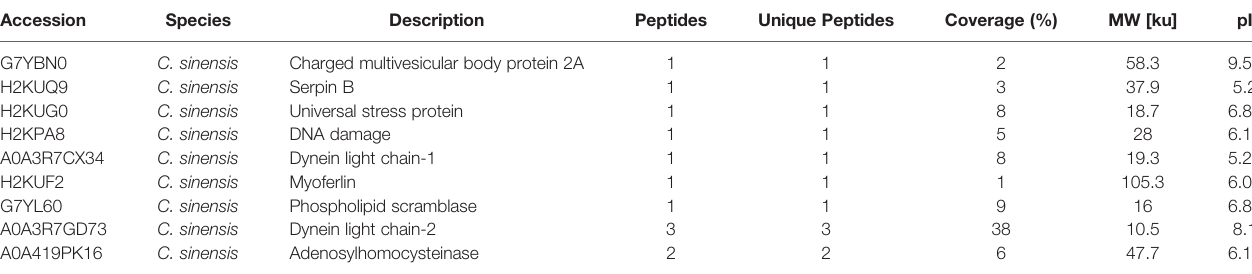
TABLE 2 | Clonorchis sinensis excretory and secretory products which were detected by sera of rabbits in 14 dpi.